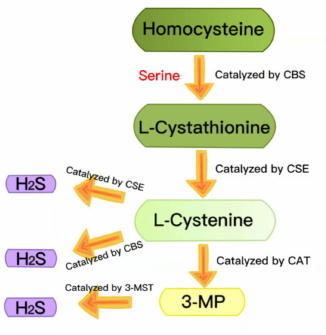
Figure 2. Summary of the production of endogenous H2S. CBS: cystathionine-beta-synthase; CSE: cystathionine-gamma-lyase; 3-MST: 3-mercaptopyruvate thiotransferase; 3-MP: 3-mercaptopyruvate; CAT: cysteine